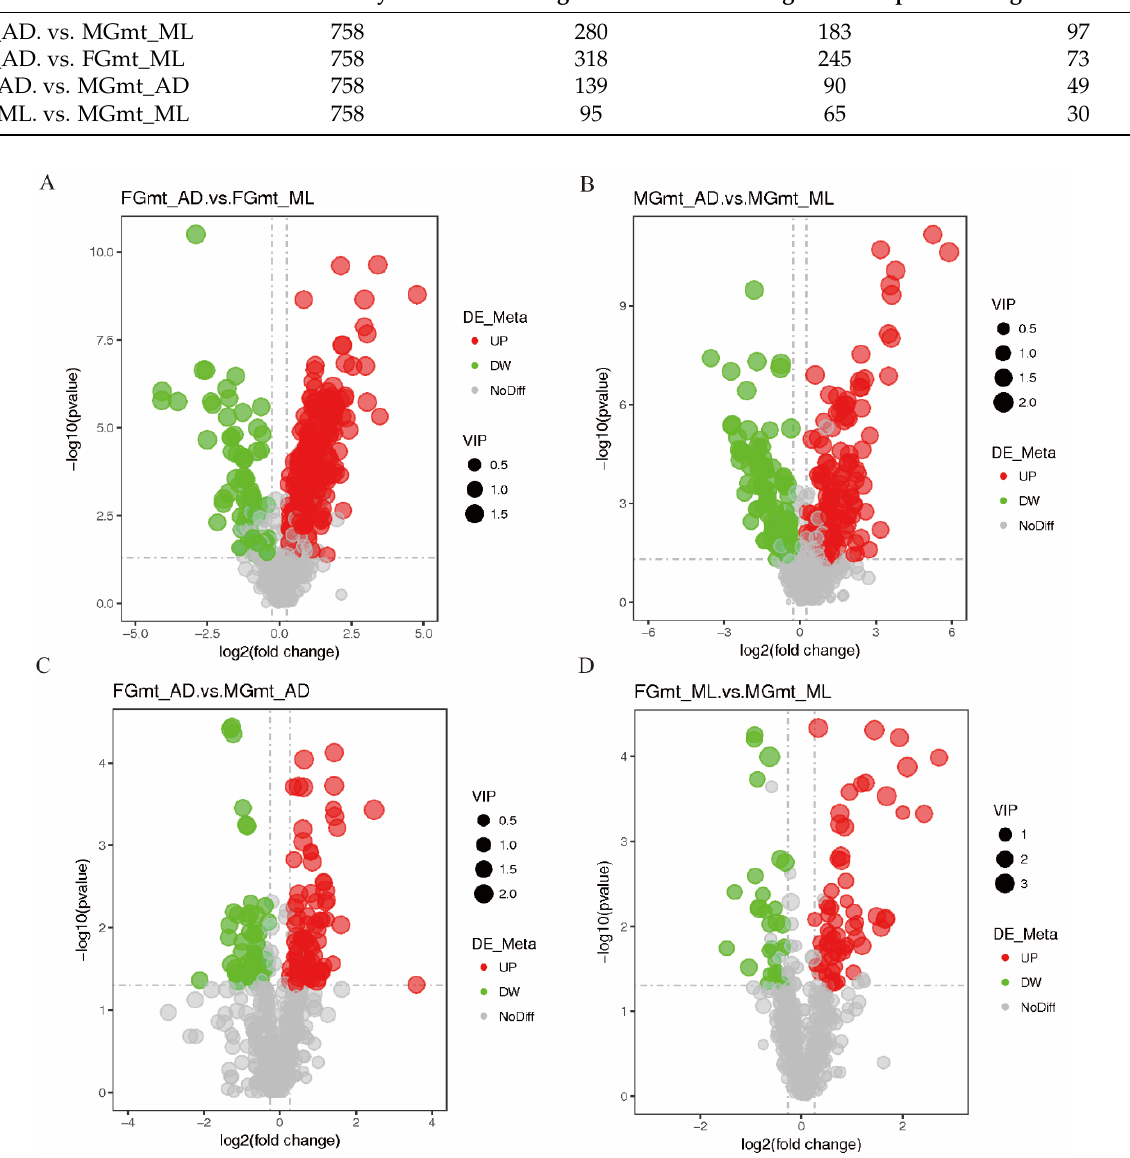
Figure 2. Volcano map of metabolites from silkworms of different genders fed on different diets. ( A )